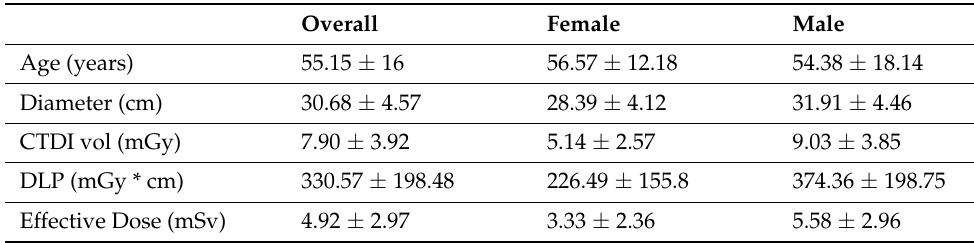
Table 2. Population data including age, calculated patient diameter which correlates directly with body mass index [16], computed tomography dose index (CTDI vol), dose length product (DLP) and effective dose calculated as described in Section 2.1.